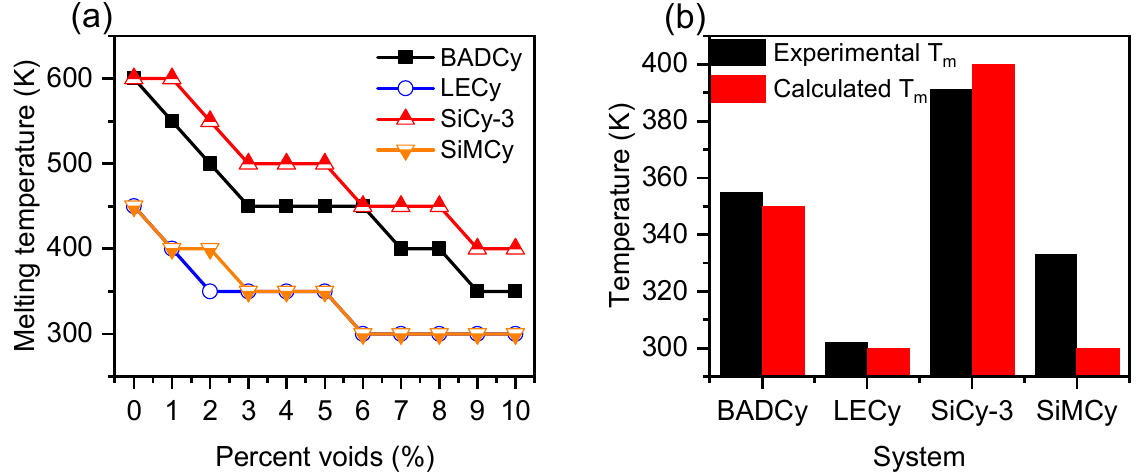
Figure 4. ( a ) The calculated melting temperature as a function of percentage voids (in % of the total monomers removed from simulation cell) and ( b ) calculated T m at 9% voids compared to experimental T m .